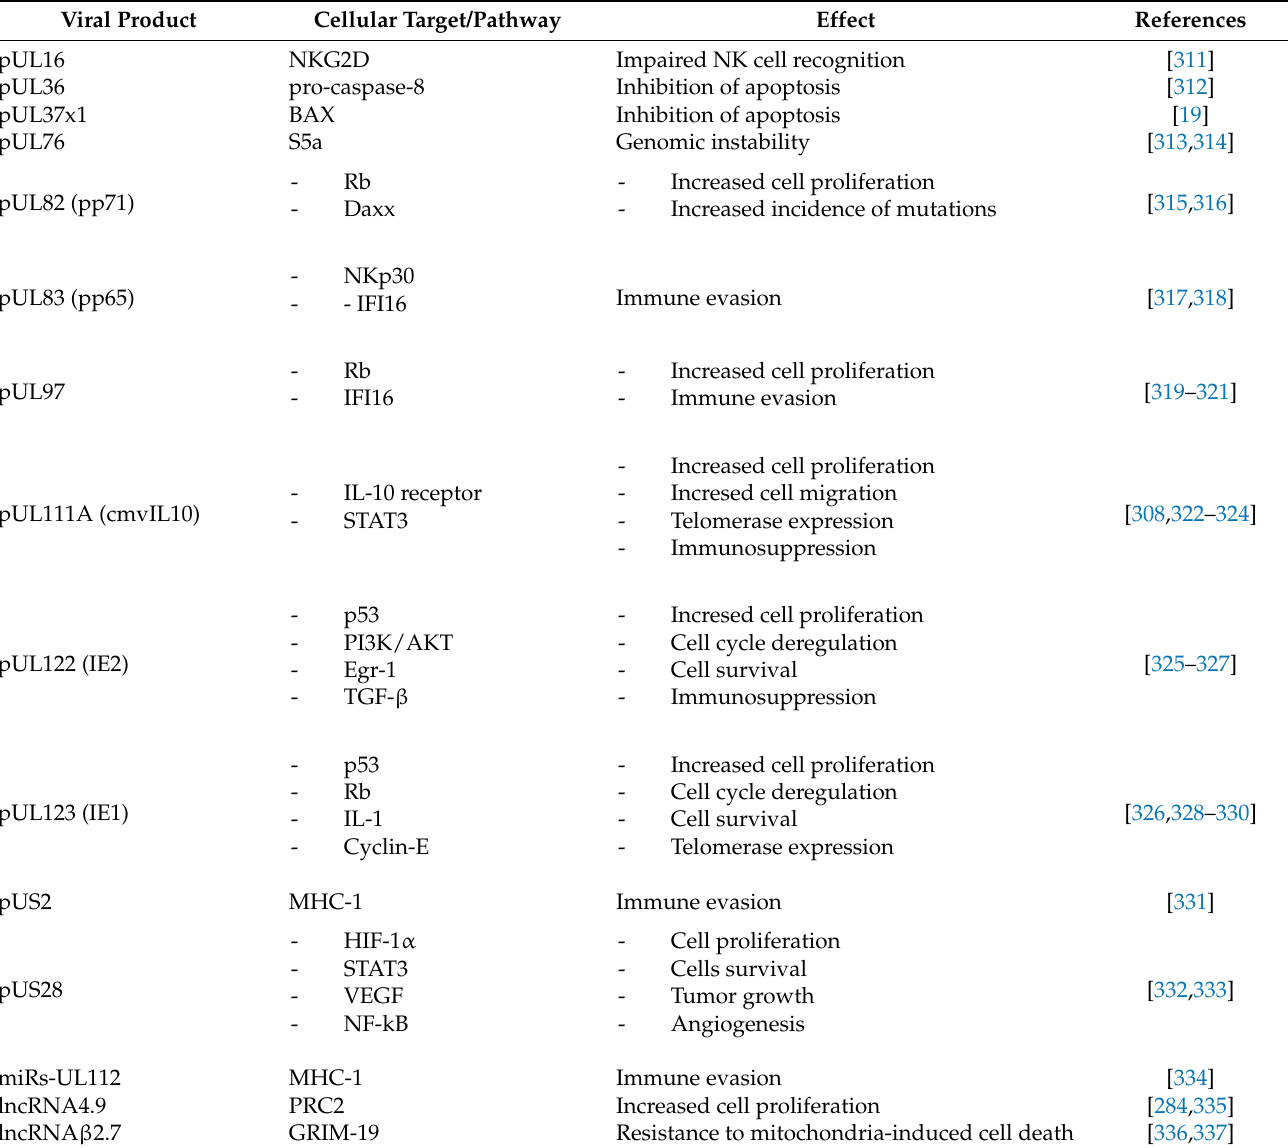
Table 2. Human cytomegalovirus products and their reported oncogenic effect. Viral